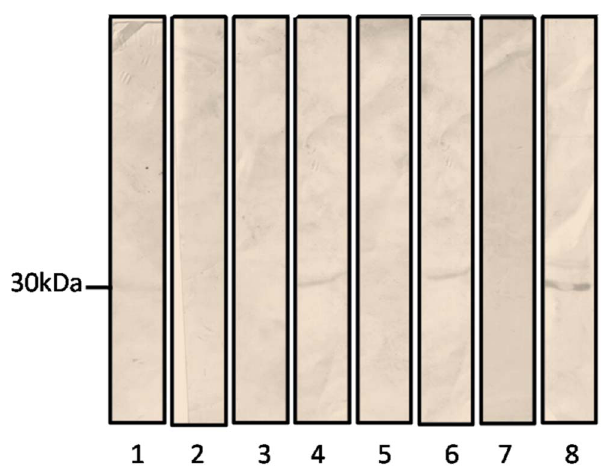
Figure 3. Immunoblotting was performed using the anti-Pb14- 3-3 polyclonal antibody to verify 14-3-3 protein reactivity. Cytoplasmic fraction from P. brasiliensis grown in Fava Nettos media (1), cell wall fraction from P. brasiliensis grown in Fava Nettos media (2), and A549 cells infected with P. brasiliensis for 2 h (4), 5 h (6) and 8 h (8). The control was performed using noninfected A549 cells for 2 h (3), 5 h (5), and 8 h (7). doi:10.1371/journal.pone.0062533.g003 each other in an orderly manner depends on multiple adhesive interactions between adjacent cells and their extracellular envi- ronment and is mediated by cell adhesion molecules [69–71].